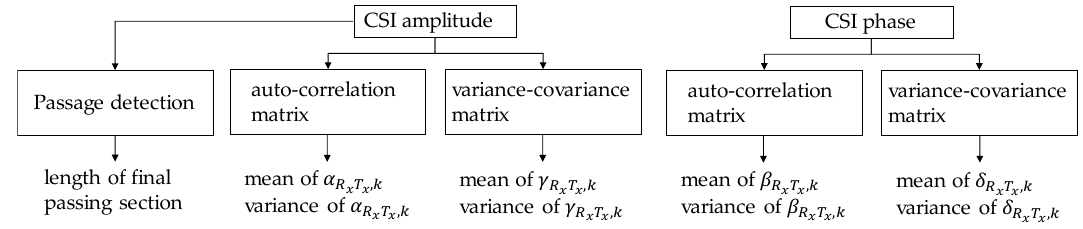
Figure 7. Summary of feature values.